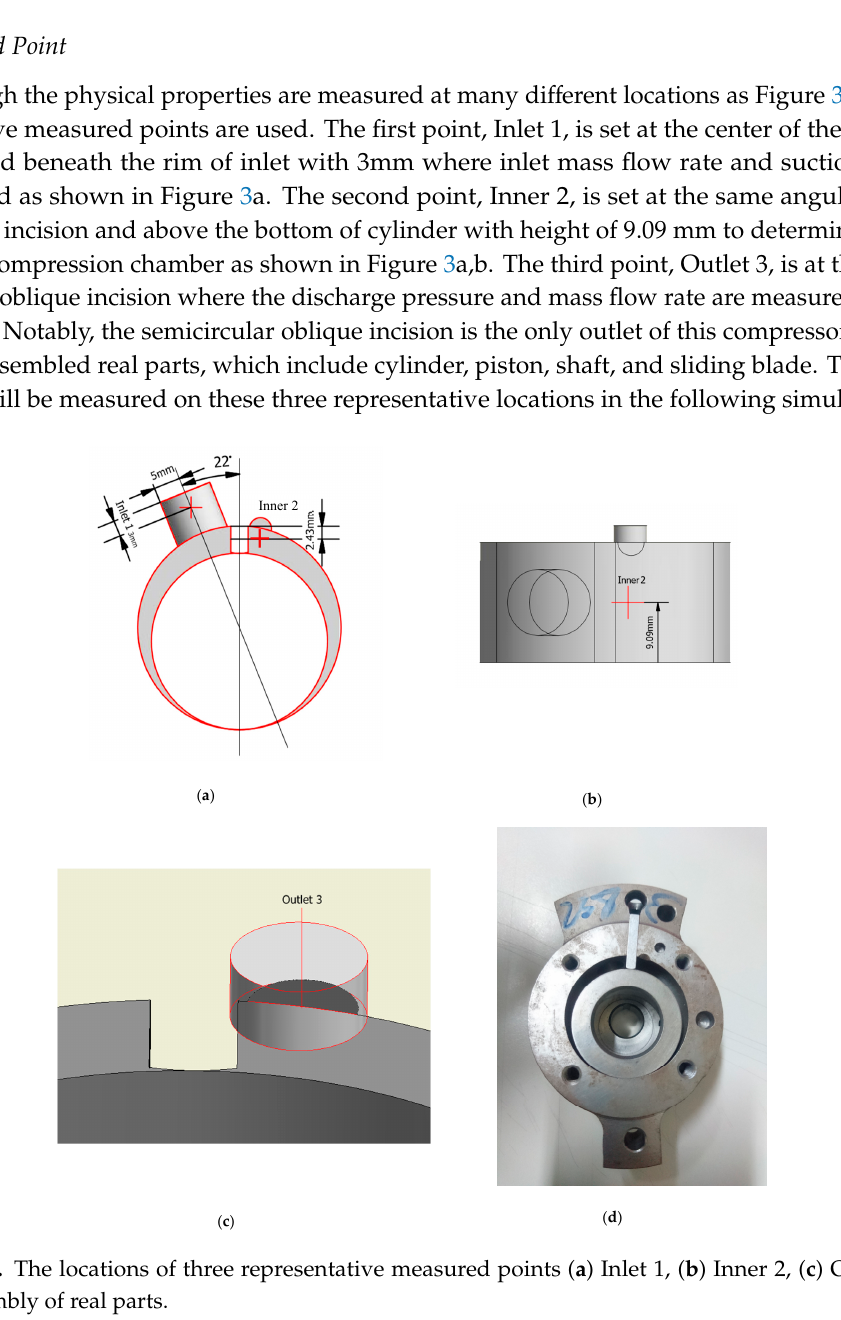
( b ) Figure 4. Grid independence test ( a ) discharge mass flow rate (at Outlet 3) at each rotation angle of piston with different number of meshes, ( b ) pressure of compression chamber at Inner 2 with different number of meshes. 3.5. Validation Two models of compressor which compression volumes are 5.2 cm 3 and 4.9 cm 3 , respectively, are tested experimentally and numerically for validation. Notably, there are different inlet conditions, including temperature and pressure in the two test models. The refrigerant, R410a, is used in experiment and simulation. The properties of R410a for simulation, including density, viscosity,